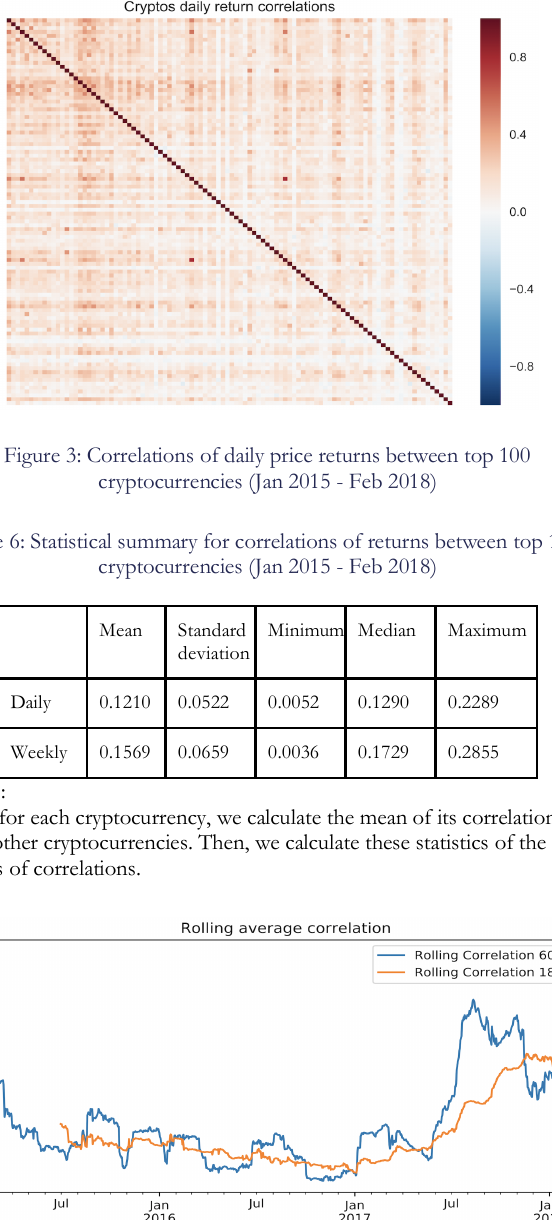
Table 4: Statistics summary for price returns of Ripple